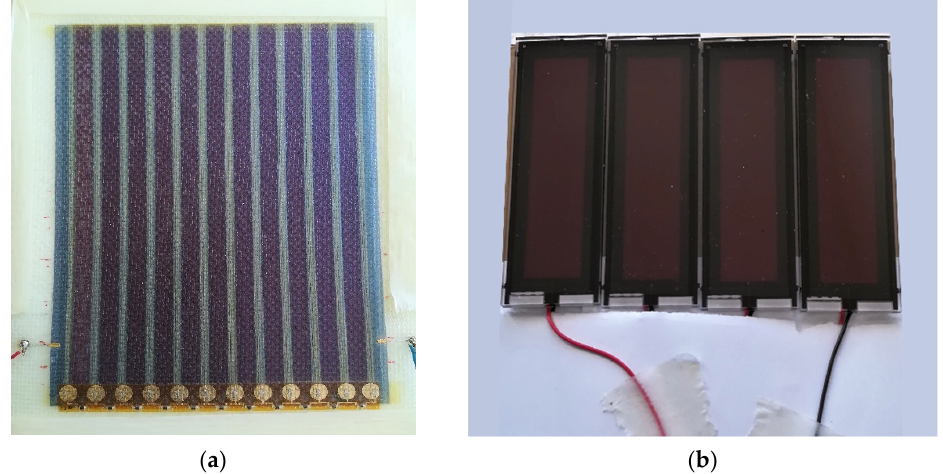
Figure 1. DSSC modules studied in this work: ( a ) flexible G24i from Gcell and ( b ) glass Fujikura FDSC ‐ FSC12FGC.